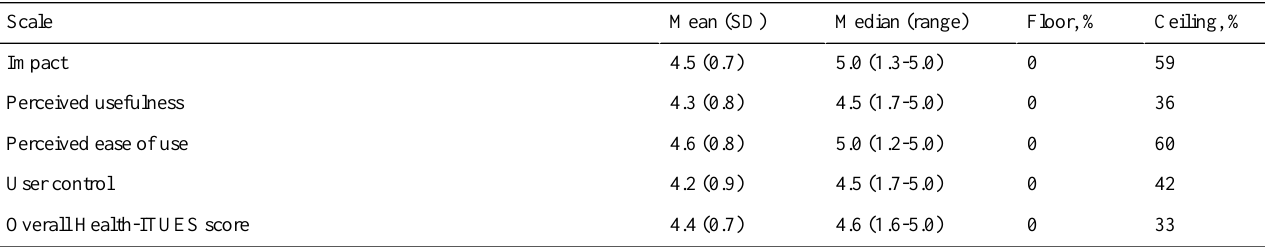
Table 3. Internal scale consistency scores and interscale correlations for Health-ITUES subscales (N=83). .85Impact